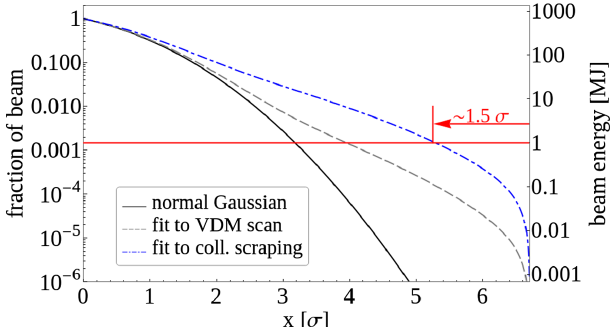
FIG. 2. Comparison of the fraction of particles outside a certain transverse position, when projected onto the horizontal or vertical axis, for three different bunch distributions: a normal Gaussian, one based on the van der Meer (VDM) scans and one based on collimator scraping measurements. The energy scale shows the corresponding energy contained in that fraction of the nominal beam. The 1 MJ limit is shown in